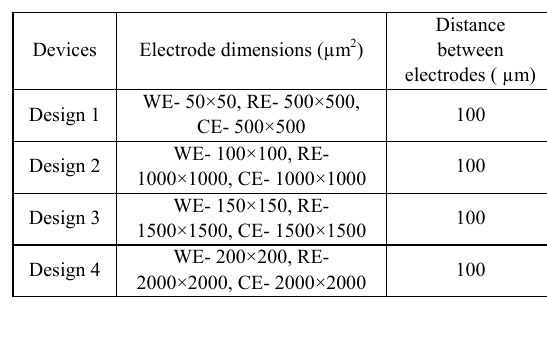
Table 1. Dimensions of different design of three electrode devices.